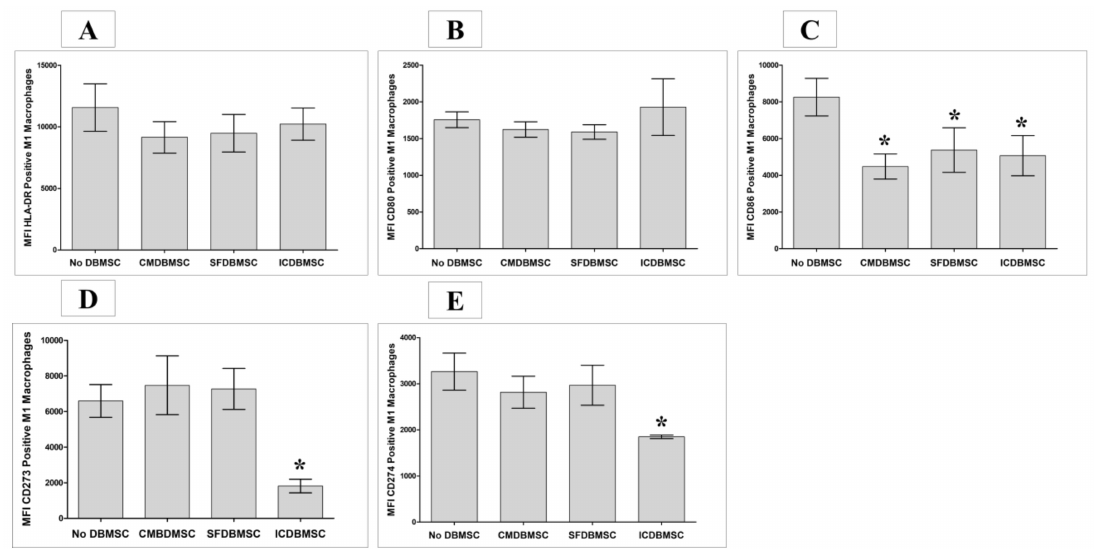
Figure 4. Effects of human DBMSCs on expression of the cell surface molecules HLADR, CD80, CD86, CD273, and CD274 by human monocytes differentiated into macrophages by GM-CSF, as analyzed by flow cytometry. After six days in culture, compared to untreated macrophages, CMDBMSCs and SFDBMSCs had no significant effects ( p > 0.05) on expression of HLA-DR ( A ), CD80 ( B ), CD273 ( D ), and CD274 ( E ) on macrophages while significantly decreasing expression of CD86 ( C ). Compared to untreated macrophages, ICDBMSCs had no significant effects ( p > 0.05) on expression of HLA-DR ( A ) and CD80 ( B ) on macrophages while significantly decreasing expression of CD86 ( C ), CD273 ( D ), and CD274 ( E ) on macrophages. Levels of expression are presented as median fluorescent intensity (MFI) as determined by flow cytometry. Experiments were carried out in duplicate and repeated 30 times using 30 individual preparations of both monocyte-derived macrophages and DBMSCs. * p < 0.05. Bars represent standard